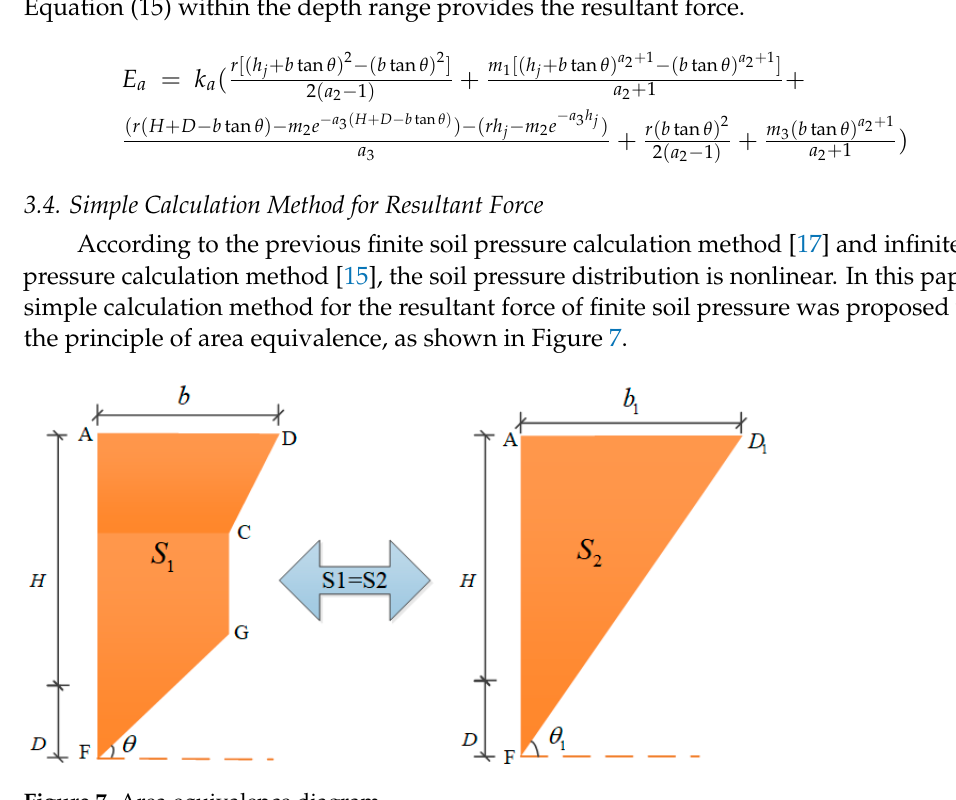
Figure 7. Area equivalence diagram.